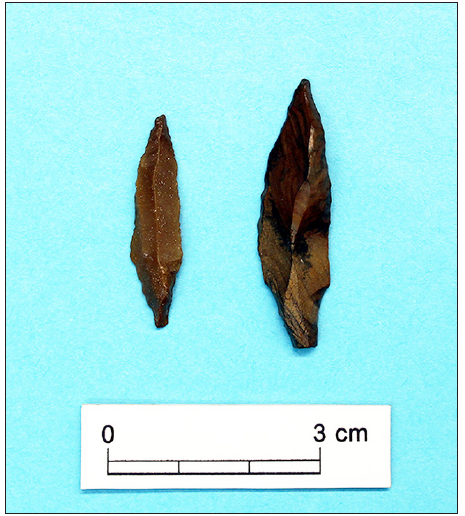
Figure 2: Ounan points from the Z Basin and Camp II (55/1197.1 and 55/1199.3 from left to right) (Photograph by author).